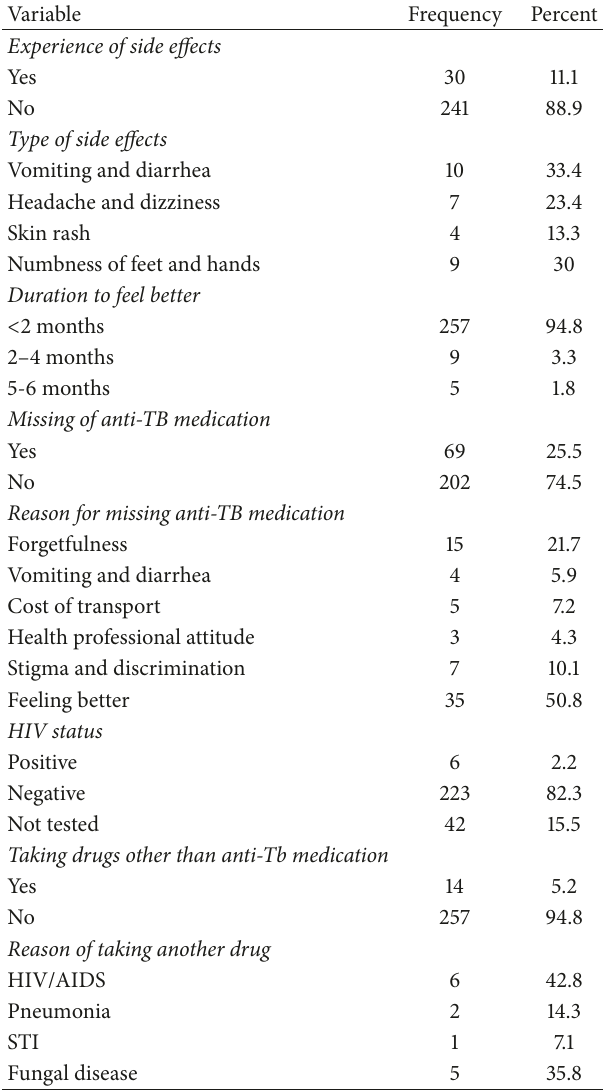
Table 4: Disease and medicine related characteristics of the TB patients that attended TB clinics at governmental health institutions of Arba Minch town, Southern Ethiopia, 2017 (𝑁 = 271)